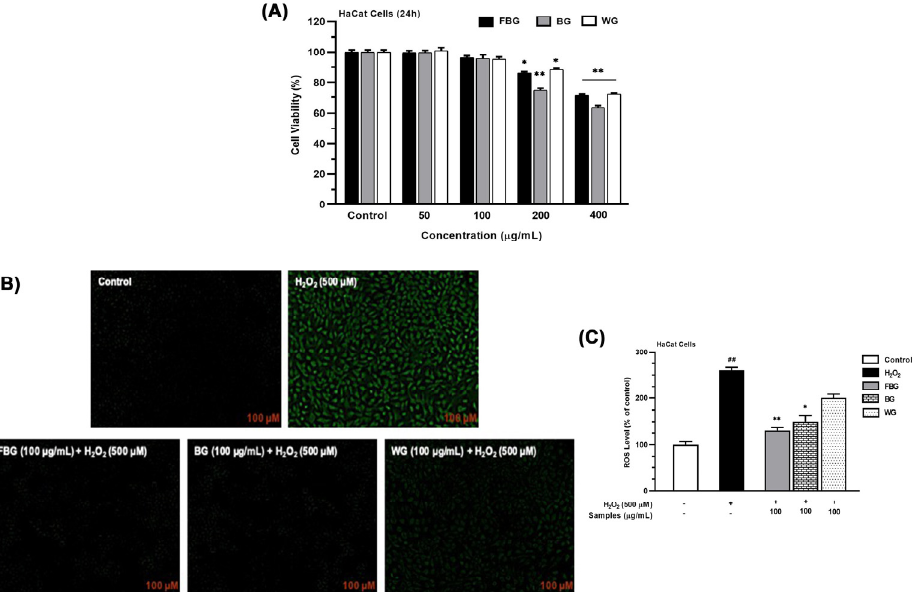
Figure 5. The antioxidant effects of FBG, BG, and WG on H 2 O 2 -induced ROS levels in HaCat cells. ( A ) Cytotoxicity effect of FBG, BG, and WG in HaCat cells for 24 h. The cytotoxicity effect was then determined with MTT assays. ( B ) HaCat cells were treated with FBG, BG, or WG (100 μ g/mL) for 24 h before exposure to H 2 O 2 (500 μ M) for 2 h. ROS level was detected by DCFH-DA and examined with a 10x fluorescence microscope. Scale bar: 100 μ M. ( C ) Intracellular ROS level (% of control). The graph shows mean ± SD values of four replicates. ## p < 0.01, as compared with the control group; * p < 0.05, ** p < 0.01, as compared with the H 2 O 2 stimulation group.